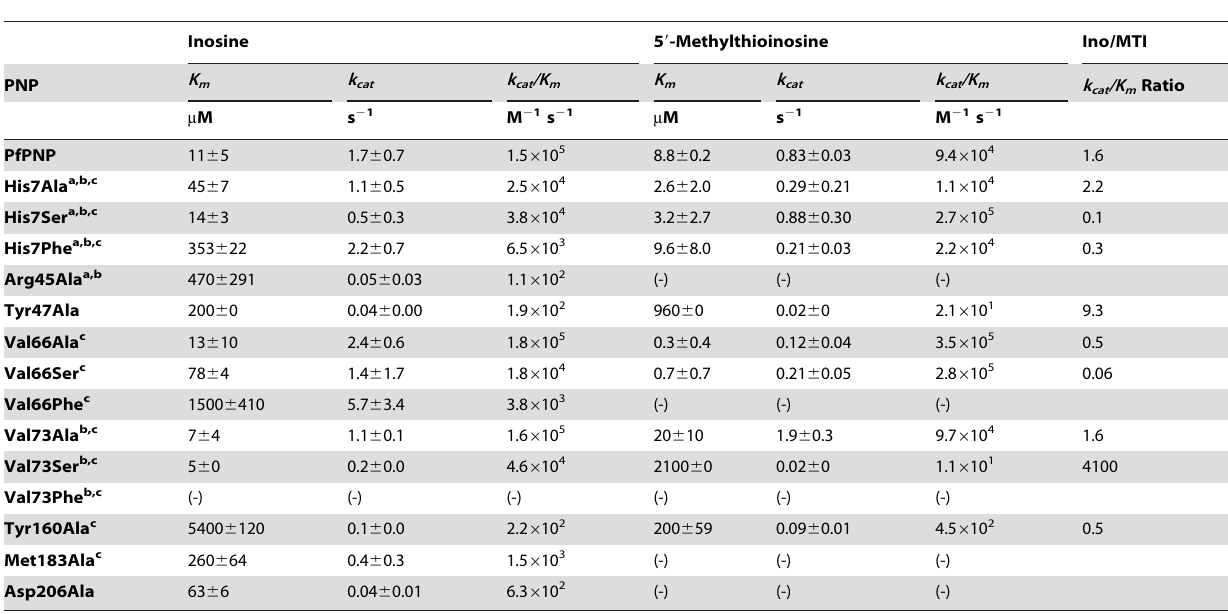
Table 1. Kinetic constants for mutant and wild type PNPs from P. falciparum and T. gondii .